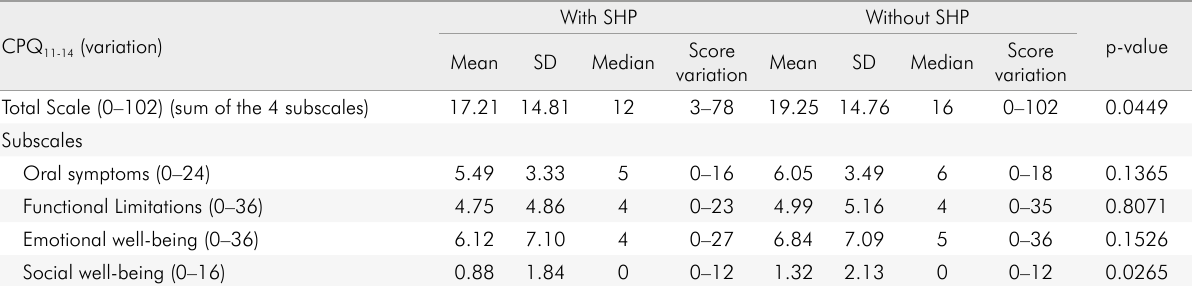
Table 3. Comparison of total means and by subscales of CPQ Friburgo-RJ, Brazil,